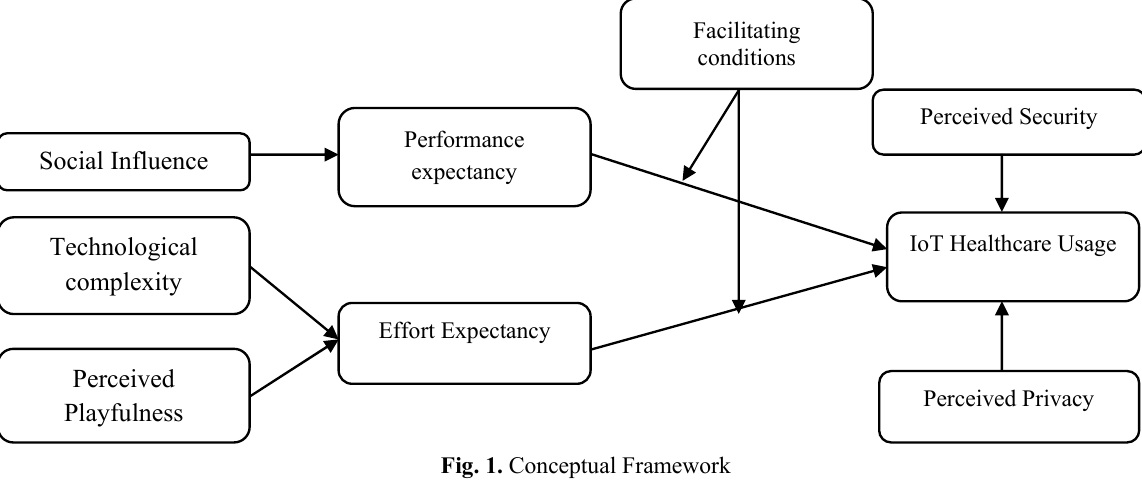
Fig. 1. Conceptual